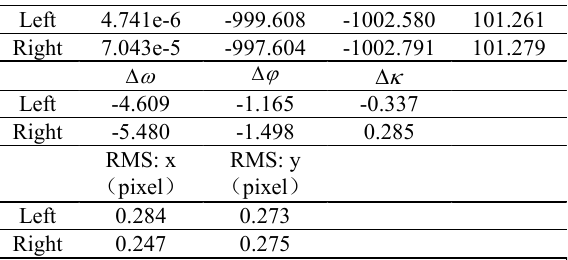
Table 2. Calibration results of the stereo cameras.